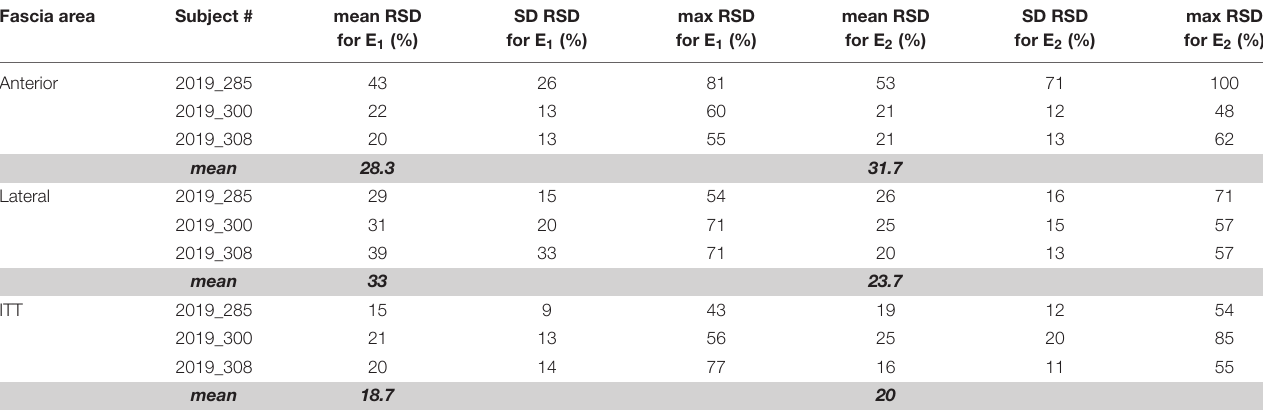
FIGURE 7 | Mean strain distributions over the knee angles for the ITT. In blue, mean major principal strain E 1 , in red, minor principal strain E 2 , and in black maximal shear strain maxE xy . For each test, all cycles are plotted. Vertical dashed line represents the knee position chosen as reference: 47 ◦ . Three other vertical lines locate knee angles of 20 ◦ , 60 ◦ , and 90 ◦ . TABLE 2 | Mean, standard deviation (SD) and maximum relative standard deviations (RSD) for each area of fascia, for each subject, and for both major E 1 and minor E 2